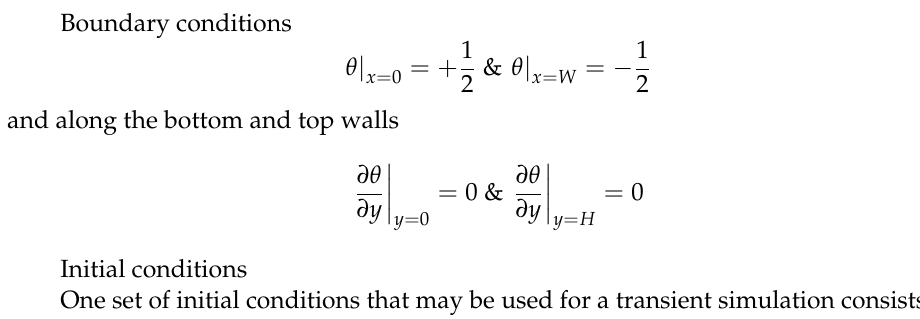
Figure 3. Differentially heated enclosure with 8:1 aspect ratio (not to scale), with insulated horizontal walls and isothermal vertical walls.